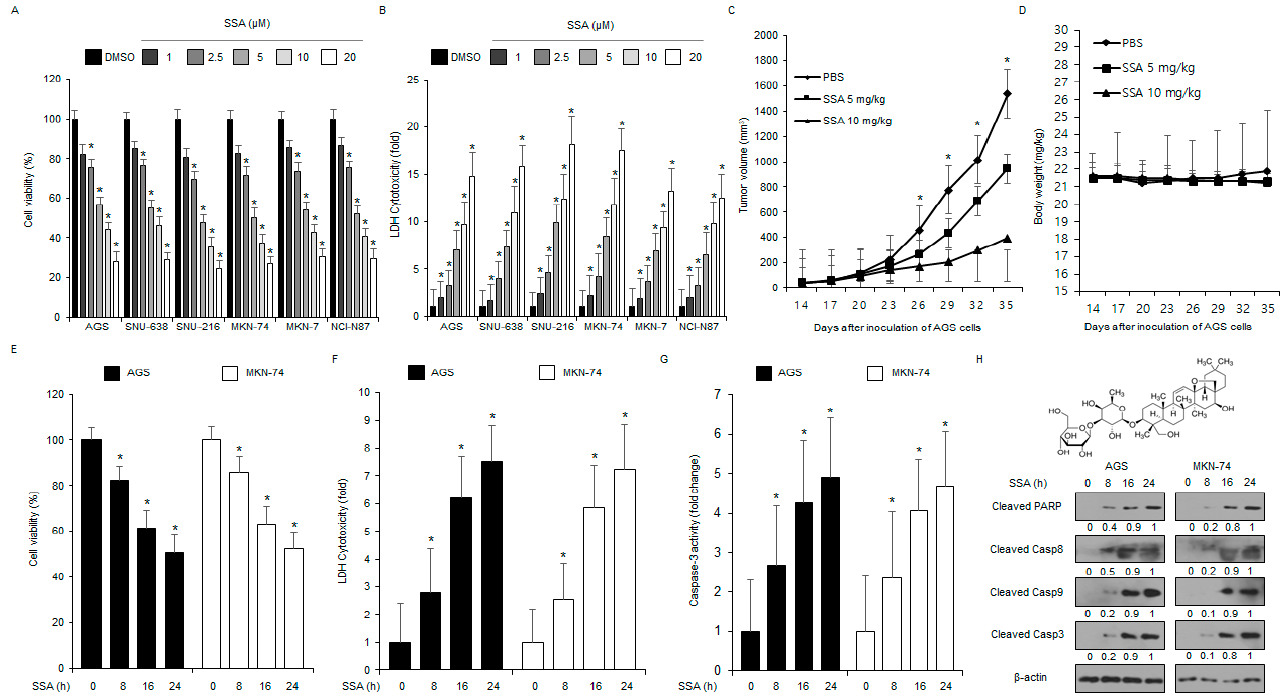
Figure 1. Anti-gastric cancer effect of saikosaponin A (SSA) in vitro and in vivo. ( A , B ) Cell viability and LDH cytotoxicity of SSA in GC cells (AGS, SNU-638, SNU-216, MKN-74, MKN-7, and NCI-N87) determined using WST-1 and LDH assays, and SSA was treated in a dose-dependent manner (0, 1, 2.5, 5, 10, and 20 µ M, 24 h). Cell viability of the DMSO-treated cells was set at 100%; *, p < 0.05. ( C , D ) AGS cells (1 × 10 7 ) were implanted (sc) into the thigh on the right hind leg of nude mice ( n = 10/group). SSA (5 or 10 mg/kg) or PBS was administered (ip) once a day for two days. Body weights of the AGS tumor-xenograft mice were determined twice a week during the experiment. ( E – H ) The cell viability, cell cytotoxicity, and caspase-3 activity in AGS and MKN-74 cells with SSA (10 µ M) in a time-dependent manner (8, 16, and 24 h) were determined using WST-1, LDH, and caspase-3 activity assays; *, p < 0.05. Western blotting of PARP, caspase-3, caspase-8, and caspase-9 cleavage were performed for the indicated times in SSA-treated AGS and MKN-74 cells. ( H ) The chemical structure of